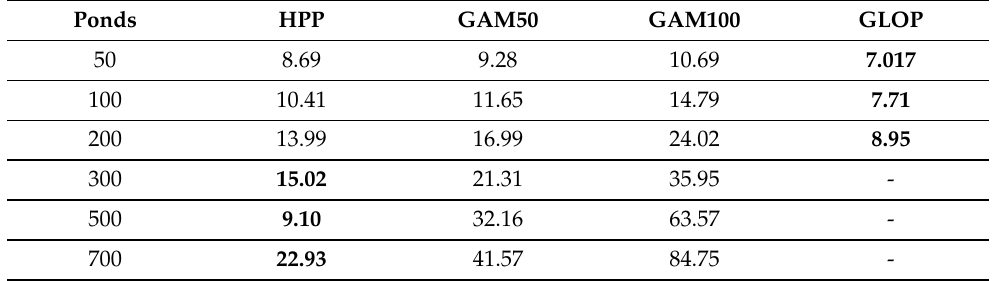
Table 4. Average Total Cost in Wind.